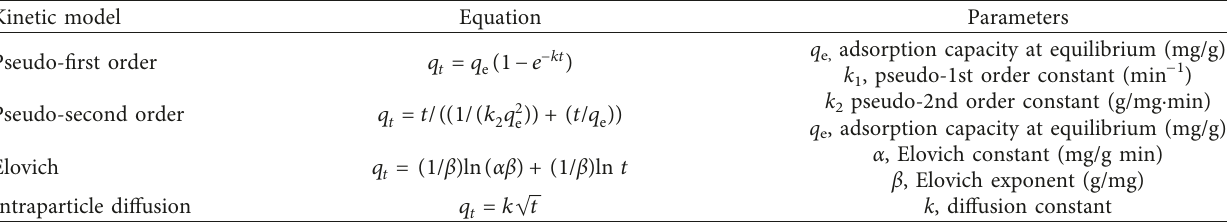
Table 1: Mathematical expressions of kinetic models.